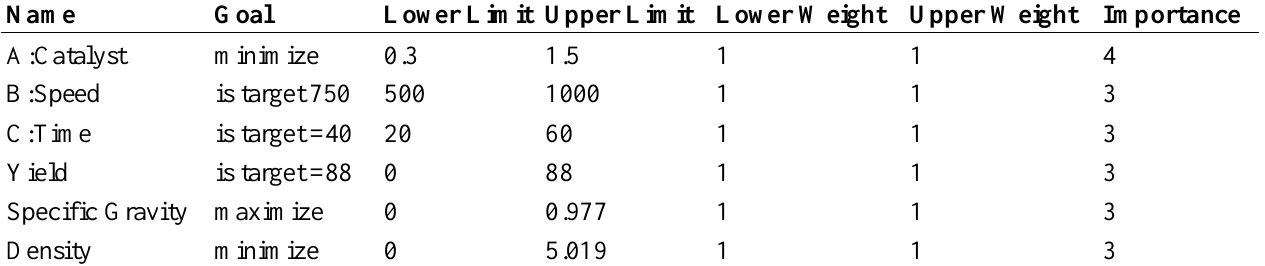
Table 6: Constraints.